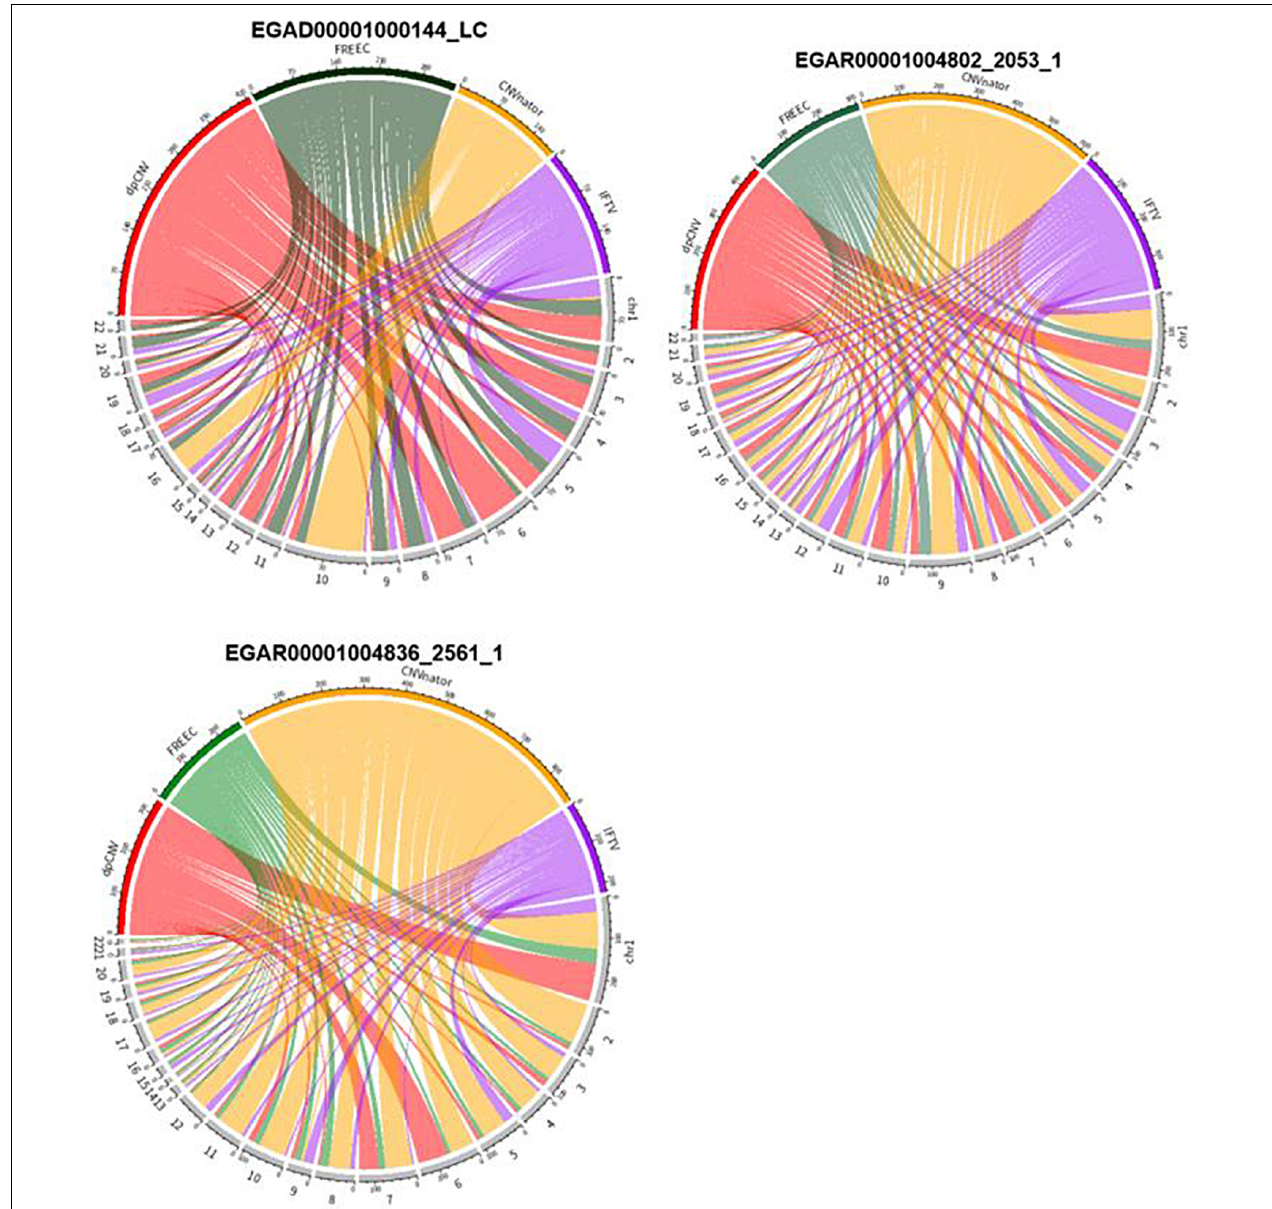
FIGURE 6 | The circus diagram on three real samples. The upper part consisting of four arcs indicates the four methods, while the lower part consisting of 22 arcs denotes 22 autosomes. The length of each arc in upper part represents the total number of detected